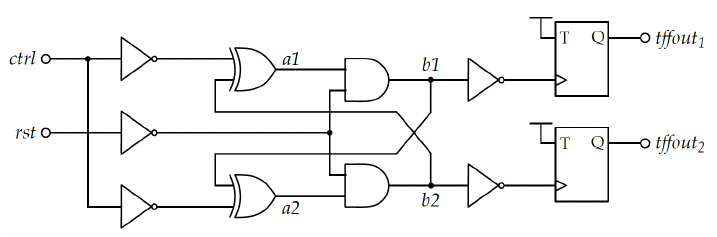
Figure 1. Transition-Effect Ring Oscillator.